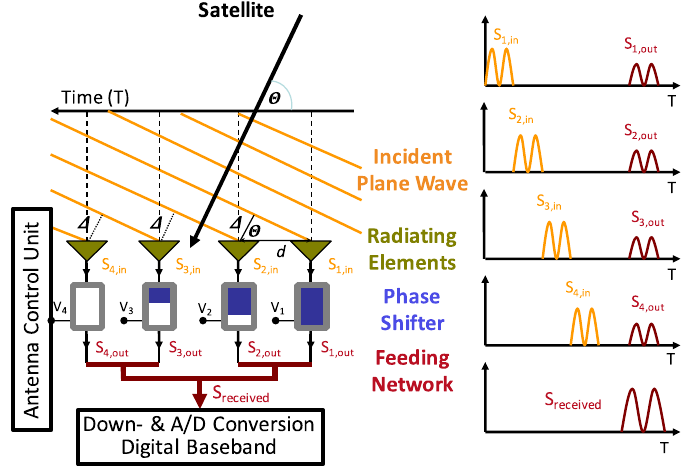
Figure 13. Sketch of an Electronically Steerable Antenna (ESA) array, receiving an incoming plane wave from a satellite ( left ) and its signal inputs and outputs ( right ).